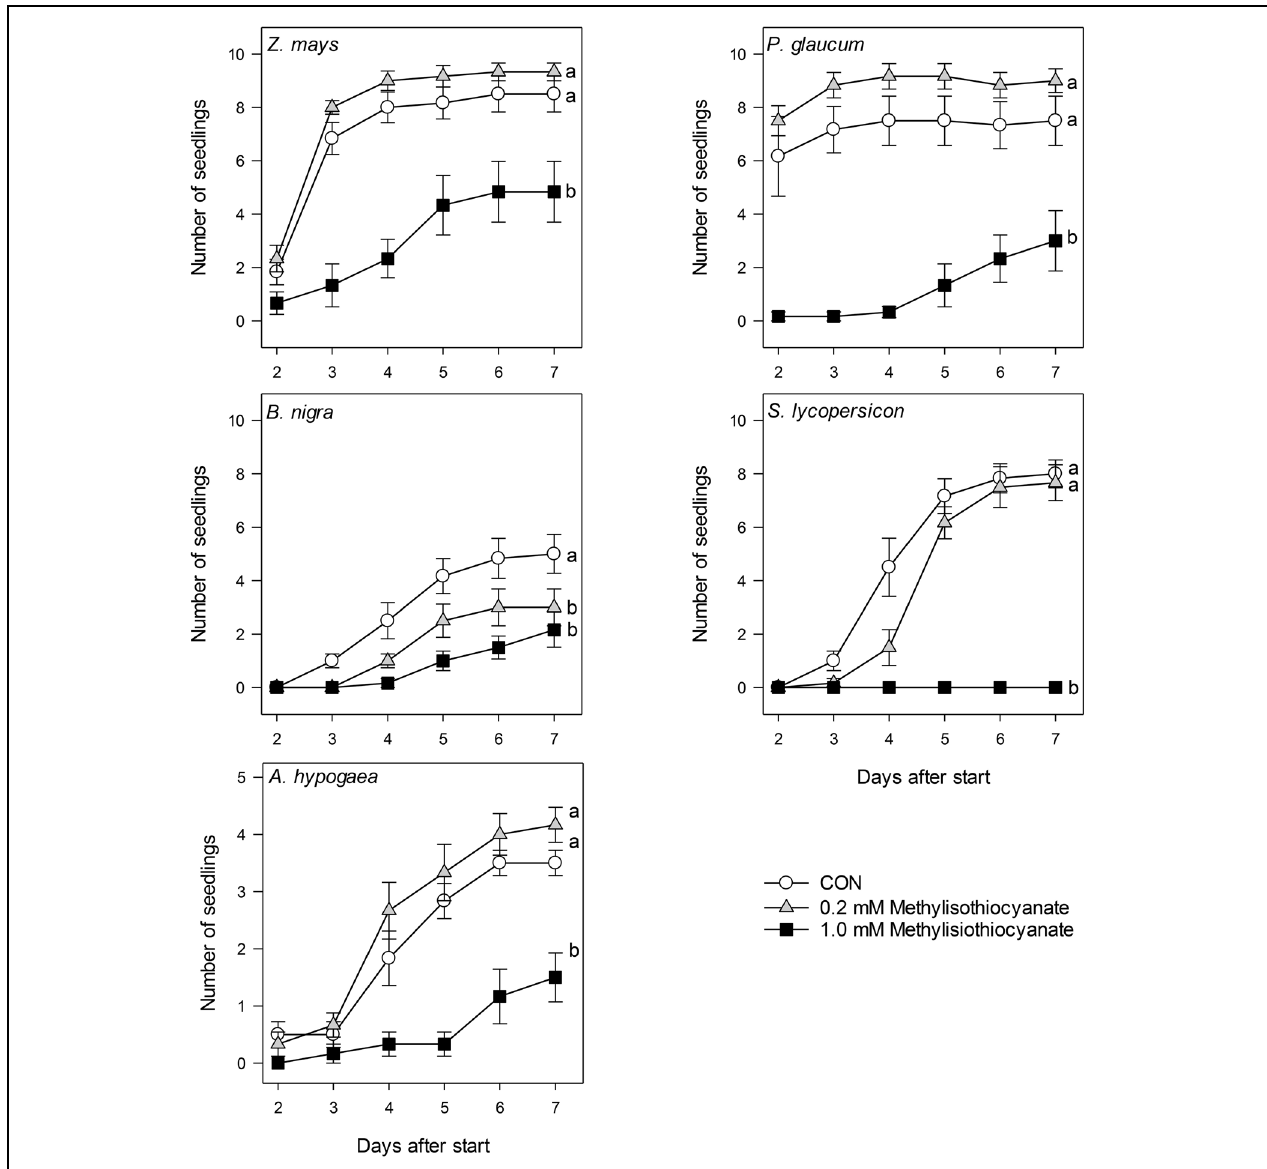
FIGURE 5 | Numbers of seedlings observed ( + SEM) from 2 to 7 days after sowing in pots watered with tap water (Con, open circles), 0.2 mM (gray triangles), or 1.0 mM MeITC (black squares) solution. Data were